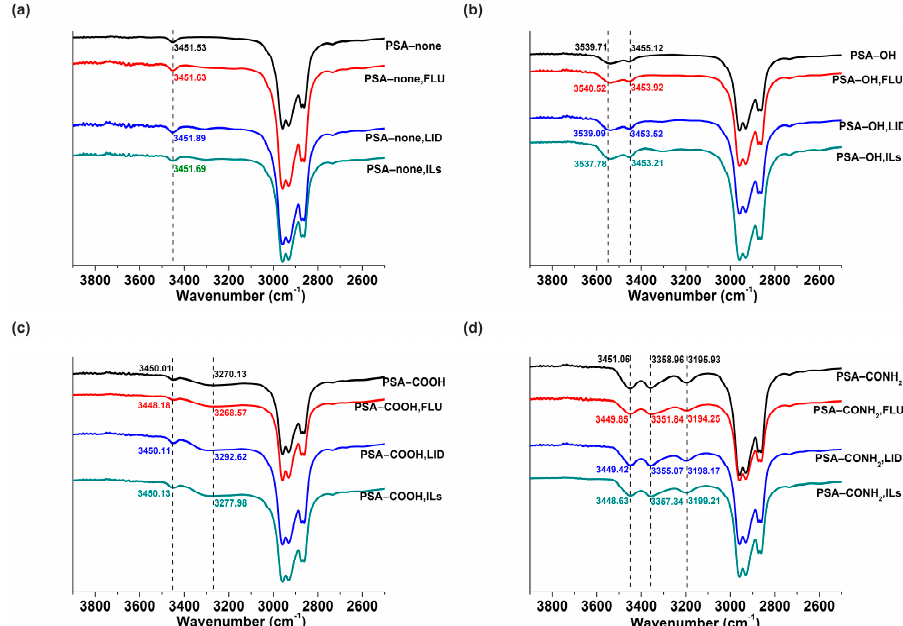
Figure 7. FTIR spectra in C=O overtone peak for the PSA − none ( a ), C=O overtone peak and OH stretching vibration peak for the PSA − OH ( b ), C=O overtone peak and O − H stretching vibrational peak of COOH for the PSA − COOH ( c ), C=O overtone peak, antisymmetric and symmetric stretching of the N − H for the PSA − CONH 2 ( d ).